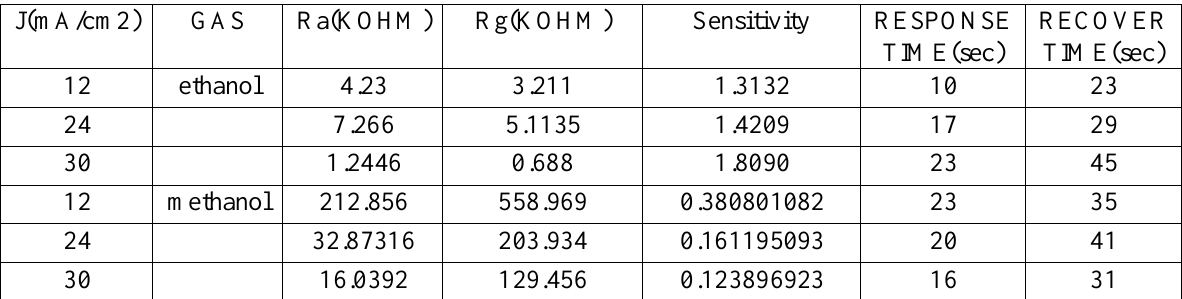
Table 2: displays the modified samples' recovery and response times